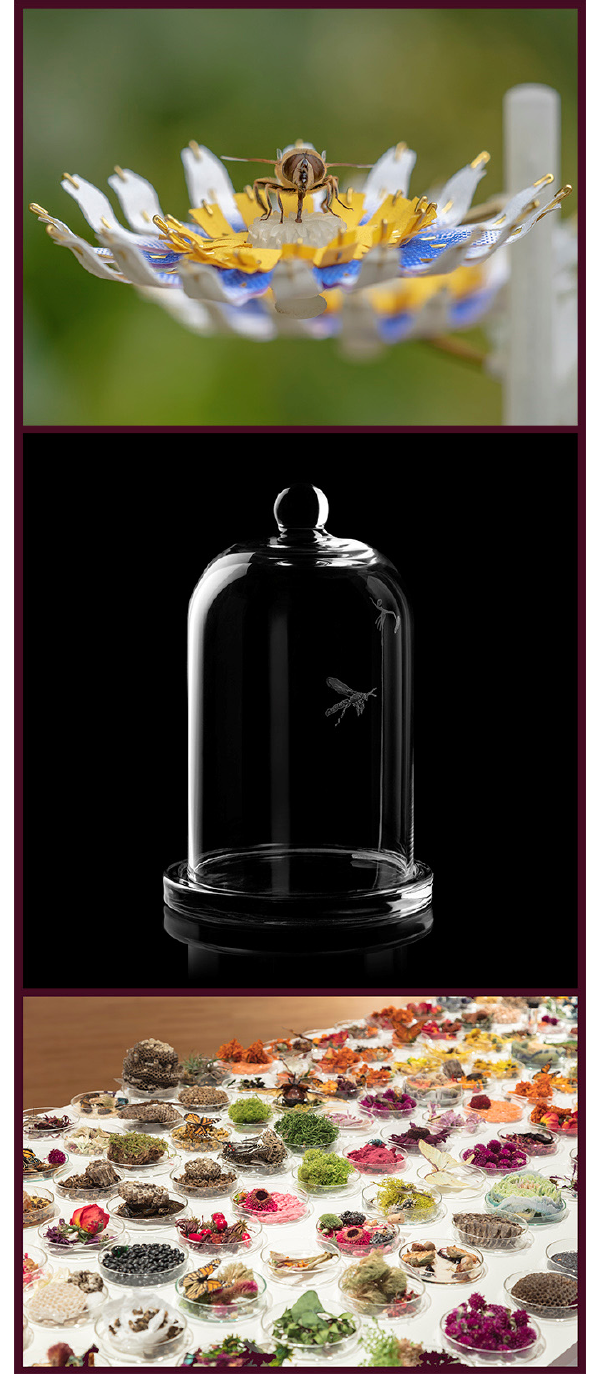
Figure 3. Insect art addressing the decline of pollinators, or concern about colony collapse disorder (CCD). Matilde Boelhouwer has worked with scientists and engineers to develop a series of artificial flowers to serve as “an emergency food source for the ‘big 5 of pollination.’” Here ( top ), a syrphid hover fly feeds from one of these flowers in Insectology: Food for Buzz (2018). In Threatened, Rare—Extant ( center ; Susan Hauri-Downing; 2018), a glass dome contains an engraved image of Zaspilothynnus gilesi Turner, 1910, a thynnine wasp that pollinates an endangered orchid, threatened by a battery of destructive acts executed by humans. Specifically addressing CCD (and bio-engineering), Suzanne Anker’s Twilight ( bottom ; 2016) includes pollinators among other natural items in Petri dishes. All images are courtesy and copyright of the